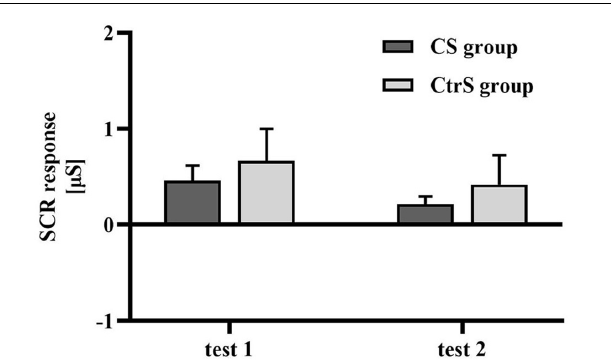
FIGURE 4 | Cue-induced SCR changes (mean ± SEM) within two cue reactivity tests for the CS group and CtrS group. SCR in both groups were significantly lower than those before